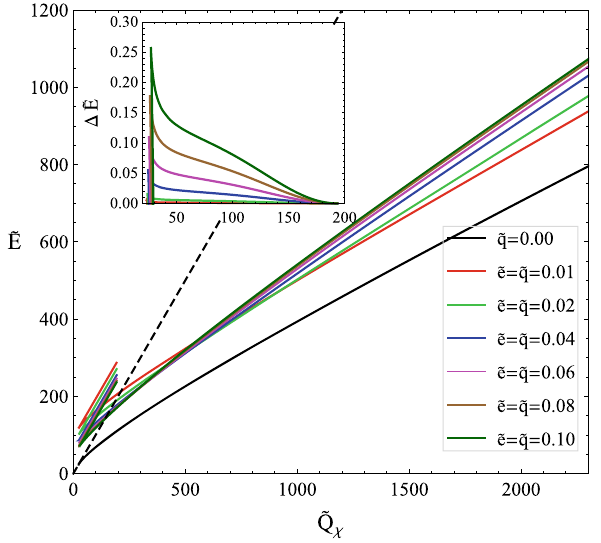
Fig. 4 Dependence of the energy ˜ E of the vortex-Q-ball system on the Noether charge ˜ Q χ for different values of the gauge coupling constants. The straight dashed line corresponds to the linear dependence ˜ E = ˜ Q χ . The subplot presents the dependence of the difference Δ ˜ E = ˜ E − ˜ Q χ −